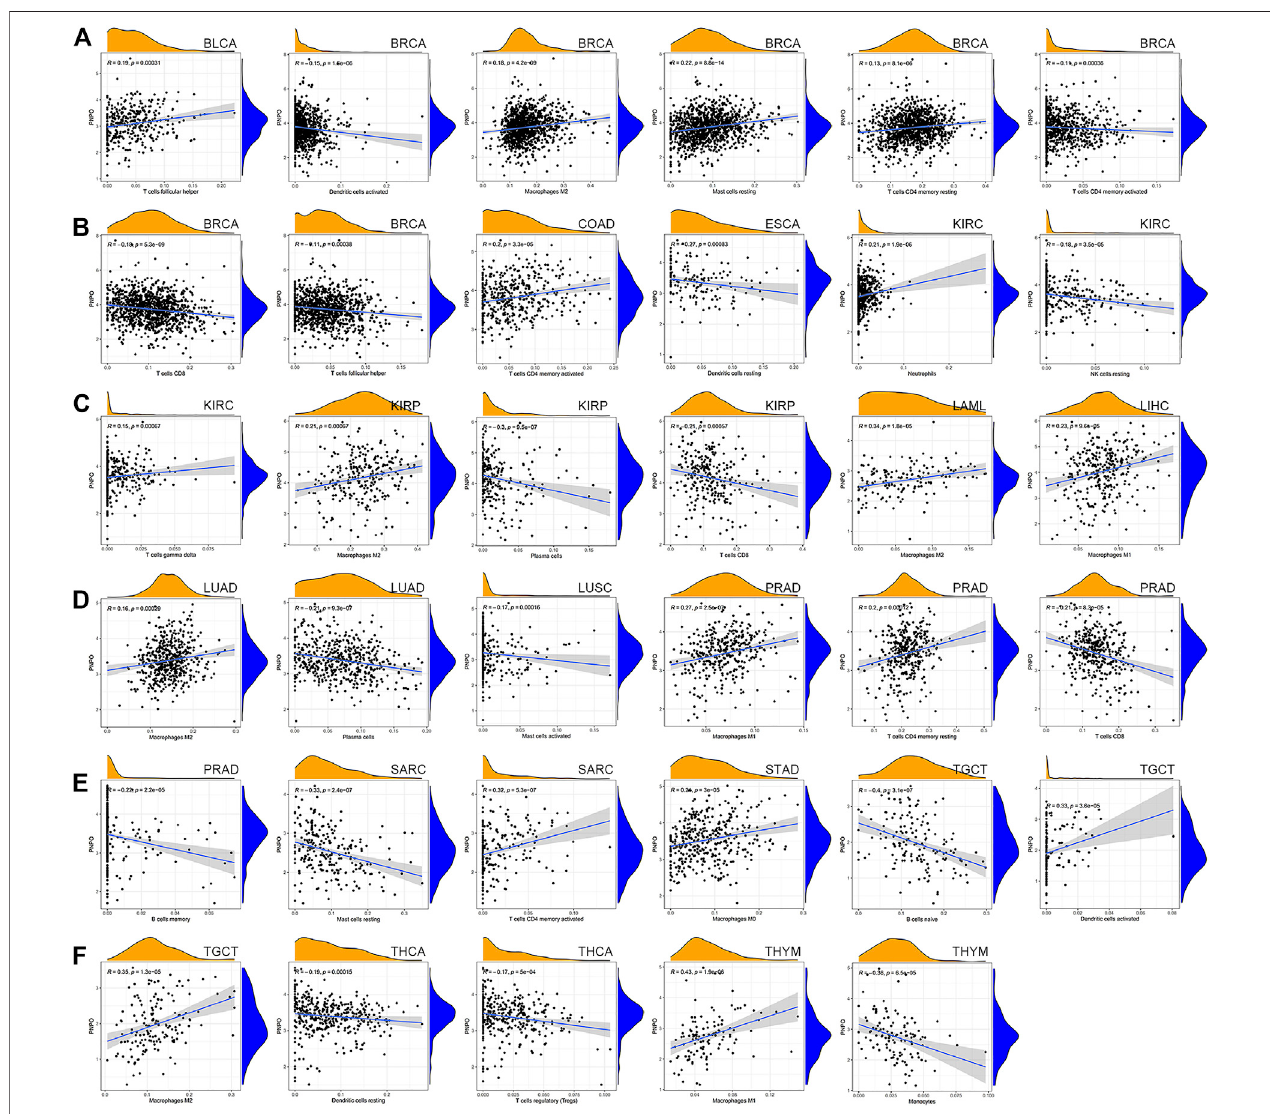
FIGURE 6 | Correlation between PNPO gene expression and tumor immune microenvironment in TCGA database. (A – F) Analysis of immune-associated cells in fi ltration with PNPO expression in pan-cancer.